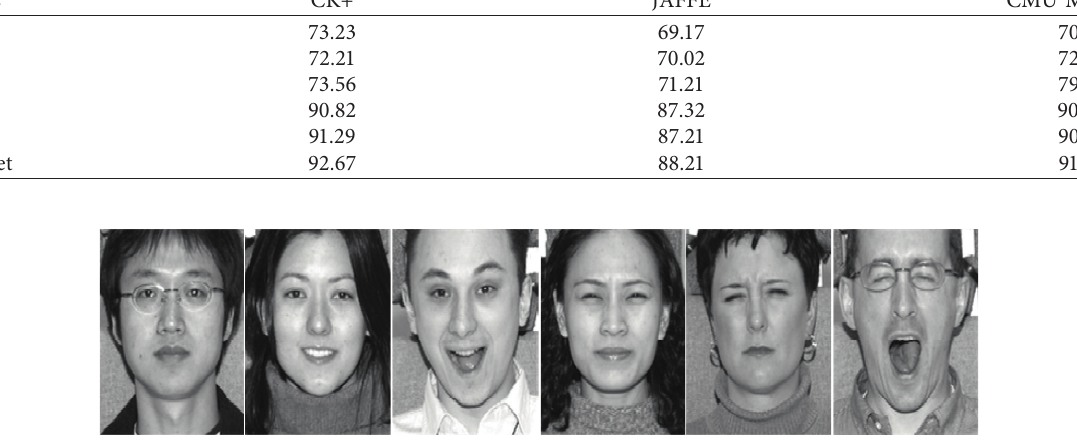
Figure 8: Partial samples of CMU Multi-PIE database.